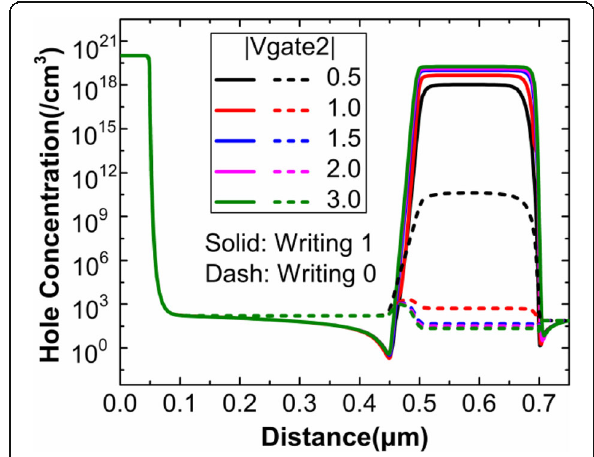
Fig. 2 Hole concentrations on the surface of the channel after writing operation. This figure shows the variations of hole concentration with the different Gate2 voltages. The cutline is taken at the surface of the device from the source region to the drain region. In this figure, the solid line and dash line represent the hole concentration after writing “ 1 ” and writing “ 0 ” , respectively